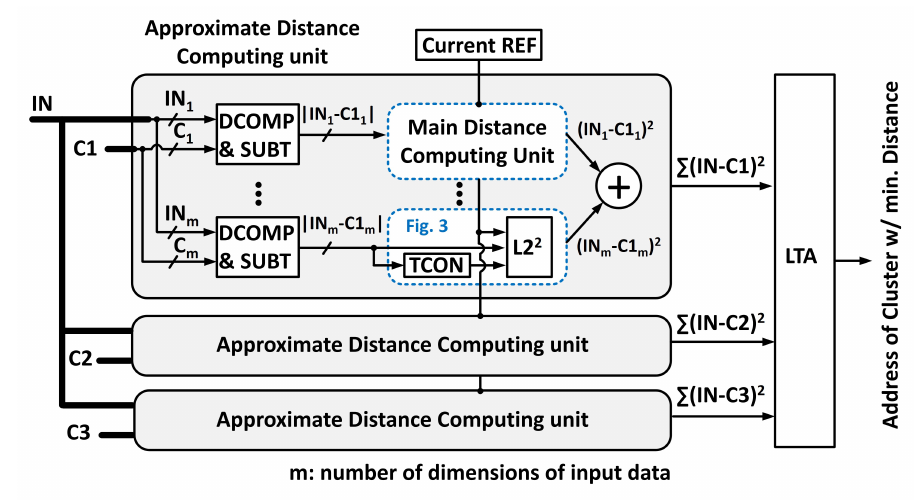
Figure 7. Architecture of the proposed “K-means clustering